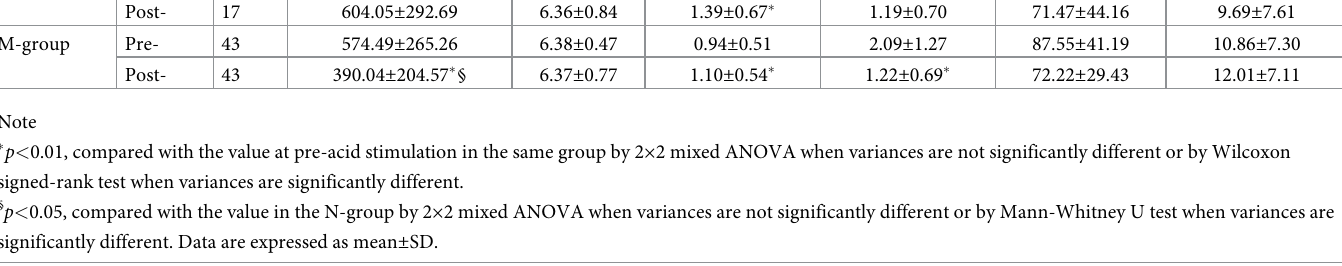
Table 3. Salivary biochemical characteristics in the N- and M-groups of MG under both pre- and post-acid stimulation conditions.